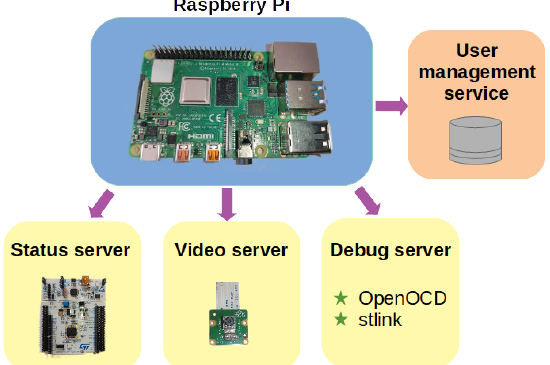
Figure 6. RemoteLab software